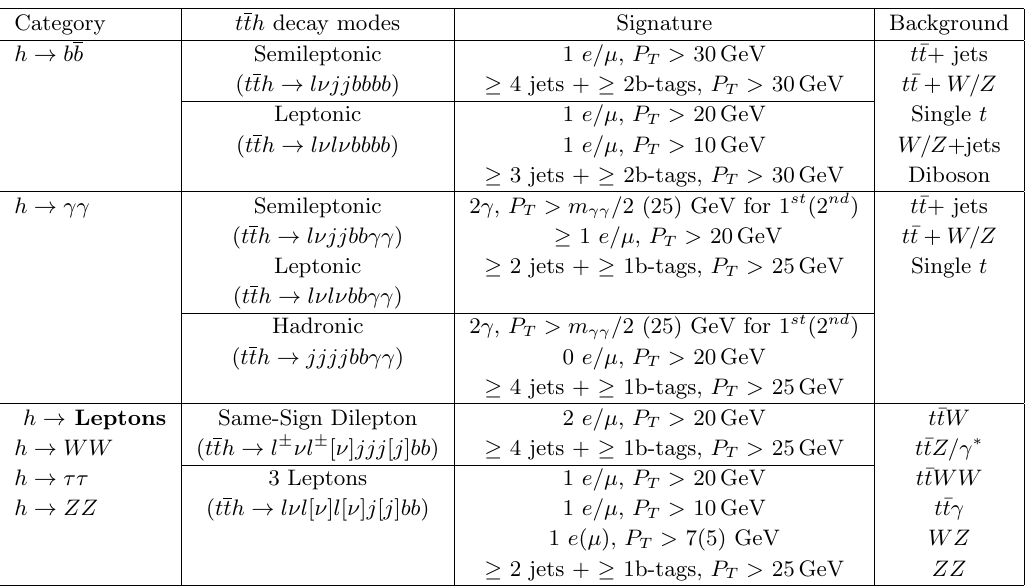
Table 2 . The signature of the search channels used in the tth analysis for CMS.